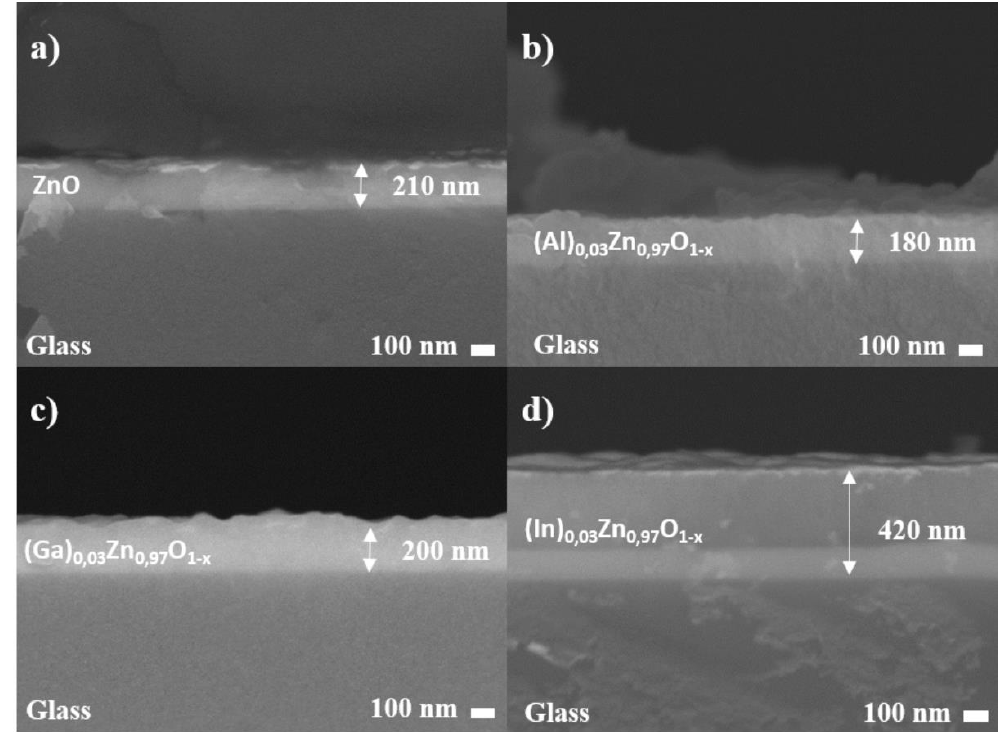
Figure 3. Cross section films images ( a ) i-ZnO, ( b ) ZnO:Al, ( c ) ZnO:Ga, and ( d ) ZnO:In .